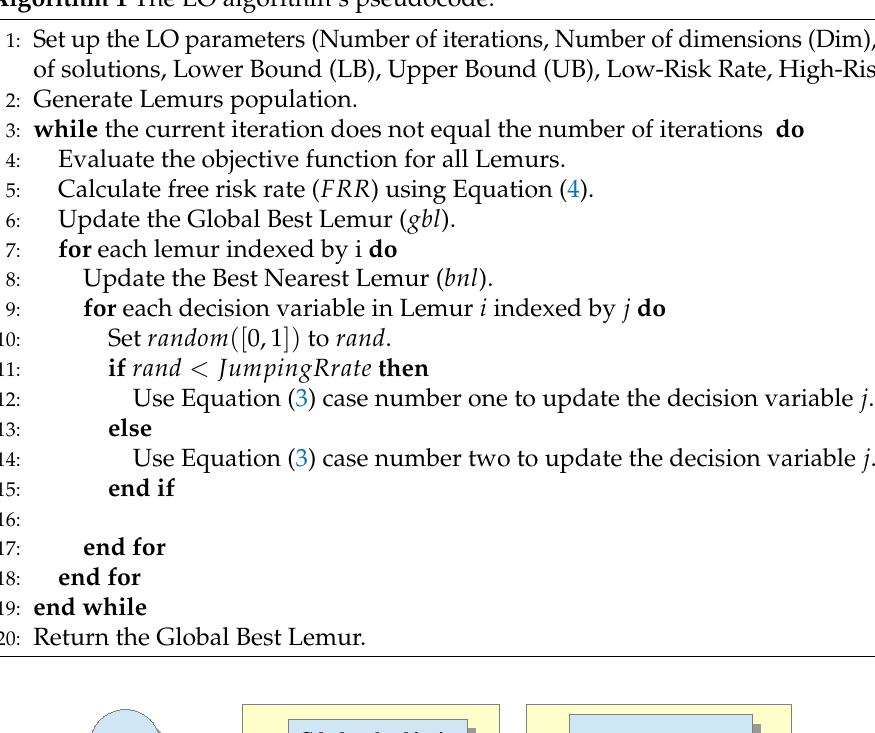
Algorithm 1 The LO algorithm’s pseudocode.